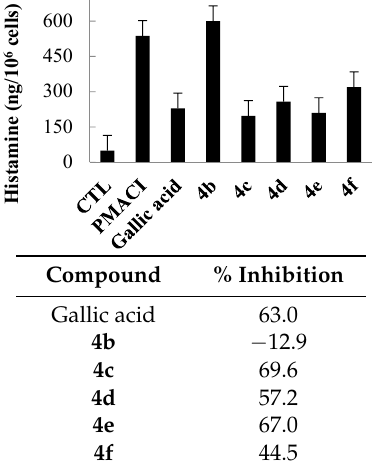
Molecules 2017 , 22 , 898 Table 2. Inhibitory activity of 3,4,5-trimethoxylamides (10 µ M) on histamine release in HMC-1 cells.